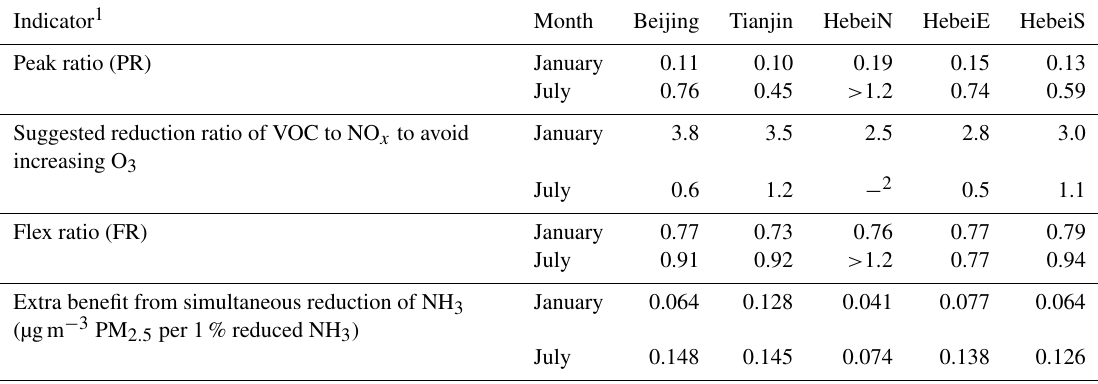
Table 4. Estimation of indicators that represent the nonlinear control effectiveness for reducing PM 2 . 5 and O 3 in the Beijing–Tianjin–Hebei region.